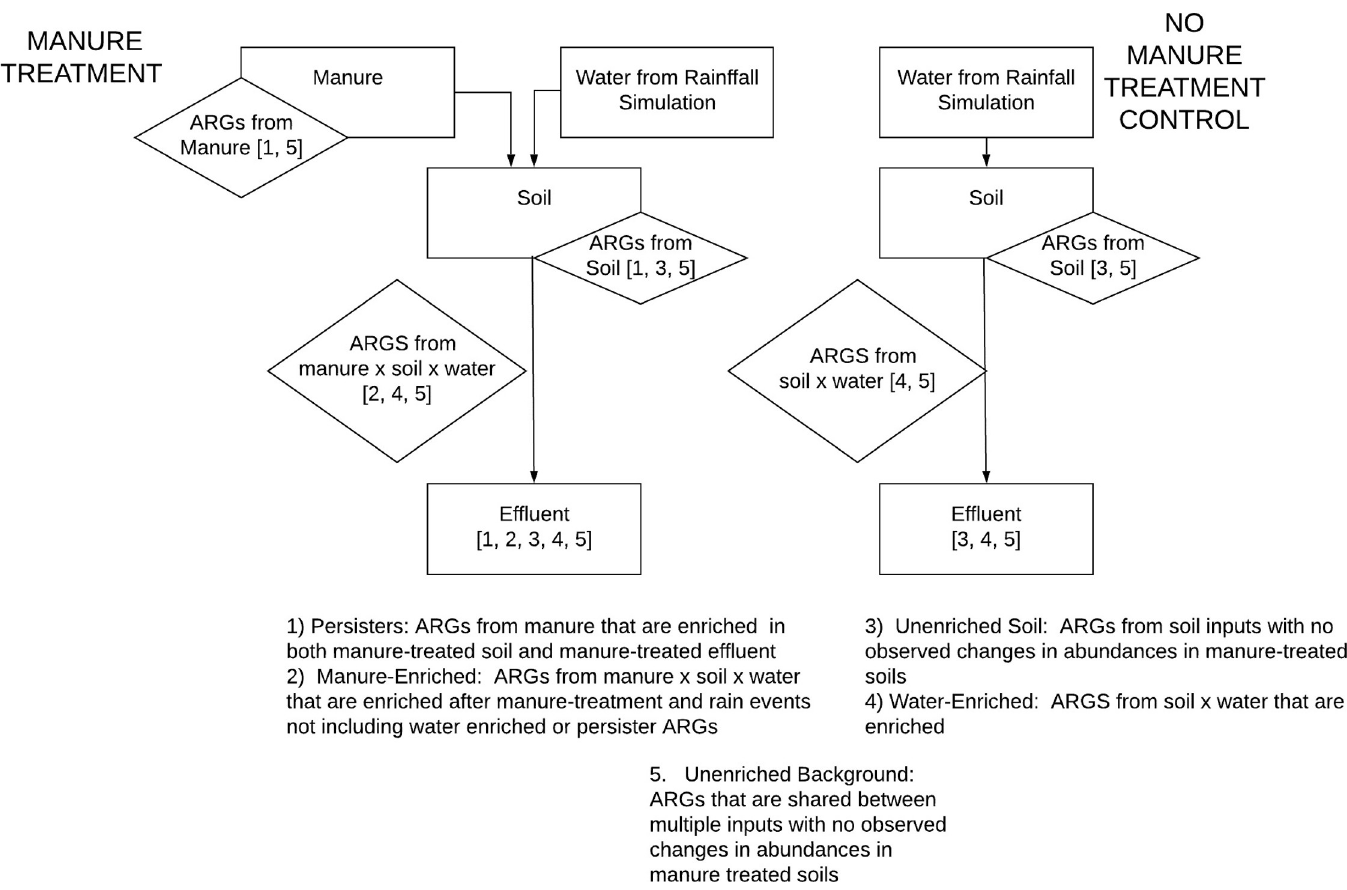
Fig 1. Classification of potential sources of ARGs in effluent from manure-treated and untreated soil columns. ARGs were categorized based on presence in one or multiple sources and observation of enrichment throughout the study. Potential ARGs from each source are shown in brackets.